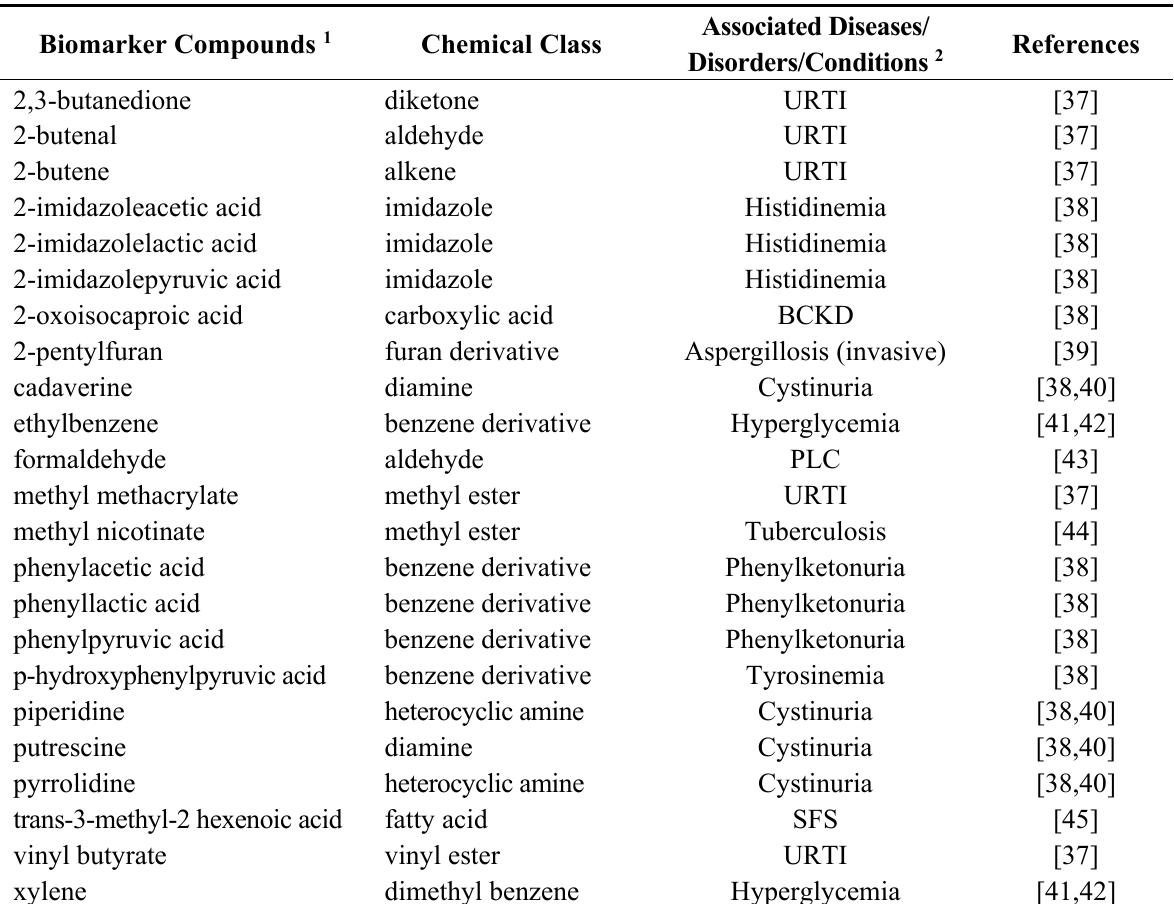
Table 1. Biomarker compounds in the human breath that appear to be uniquely